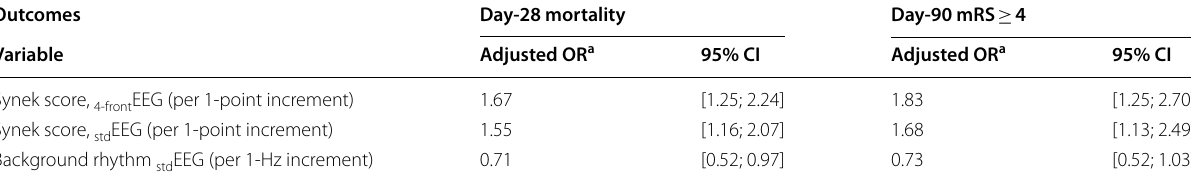
The Synek score ranges from 1 to 5, with higher scores indicating more severe encephalopathy mRS: modified Rankin scale; OR: odds ratio; EEG: electroencephalography; 4-front EEG: 4-electrode montage; std EEG: 21-electrode montage a The association between each EEG variable (background rhythm, and Synek’s scores on score 4) were evaluated using logistic regression analyses adjusted for age, pre-ECMO cardiac arrest, and non-neurological SOFA score at time of cannulation